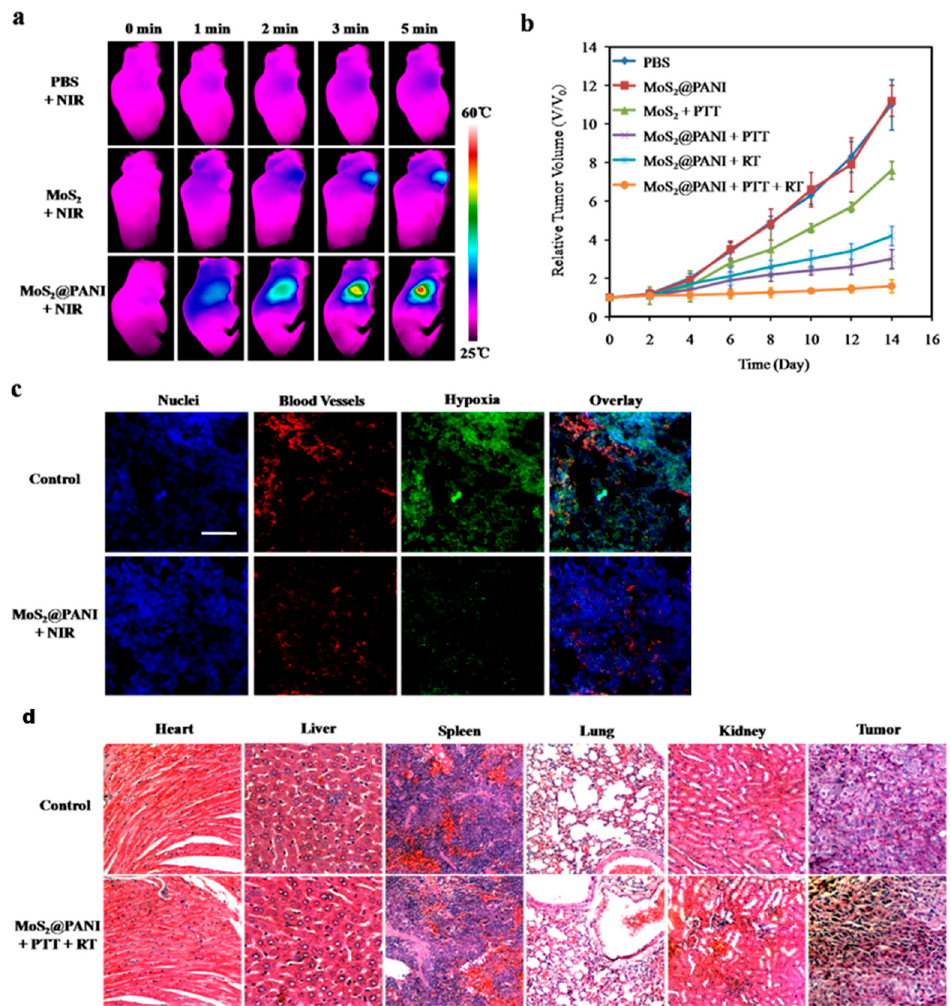
Figure 29. ( a ) Photothermal images of 4T1 tumor-bearing mice under NIR laser irradiation (808 nm) with Phosphate Buffer Saline (PBS), MoS2 and MoS2@PANI nanohybrid. ( b ) Tumor growth in different group of mice in different time frames. ( c ) Immunofluorescence image of tumor slice of nuclei stained with 2-(4-amidinophenyl)-6-indolecarbamidine dihydrochloride (DAPI, blue), blood vessels stained with anti-CD31 anti body (red), hypoxia stained with antipimonidazole antibody (green) and the overlay image. ( d ) H&E staining of various organs of mice treated differently under NIR laser irradiation and X-ray irradiation. Reproduced with permission from [192]. Copyright 2016 from the American Chemical Society.